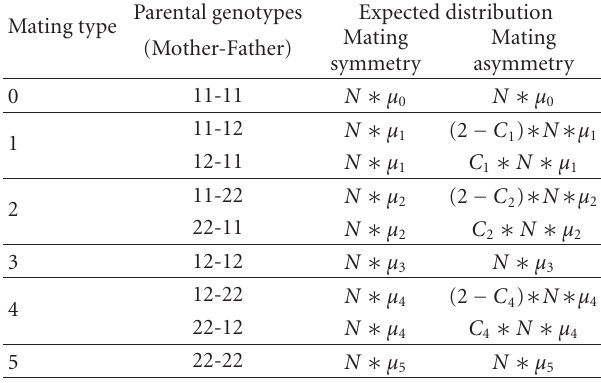
Table 3: Parental genotype distributions under mating symmetry and mating asymmetry.